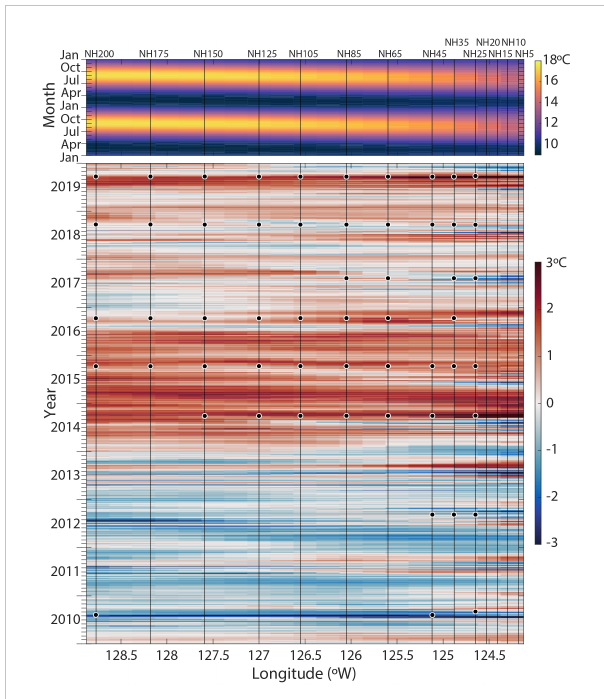
FIGURE 2 Sea-surface temperature (SST) climatology and Hovmöller plot of SST anomalies along the Newport Hydrographic (NH) Line. The 39- year (1982-2020) seasonal climatology is shown across two years in the upper panel (from OISST, see Methods). In the lower panel, SST anomalies from 2010-2019 are shown relative to the 39-year climatology. Vertical lines show the NH Line stations from NH-5 to NH-200. The date and location of each sample analyzed in this study is indicated with a black